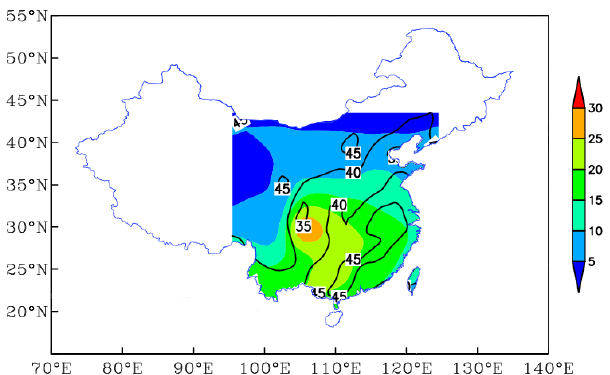
Figure 7. The percentages (%; contour lines) of differences of sur- face aerosol concentrations between the winters of 1998 and 2003 with positive Q 1 anomalies and the winters of 1996 and 2002 with negative Q 1 anomalies on the TP relative to the surface aerosol levels averaged over the winters of 1996, 1998, 2002 and 2003 (µgm − 3 ; color contours), modeled by the sensitivity simulation ex- periment with